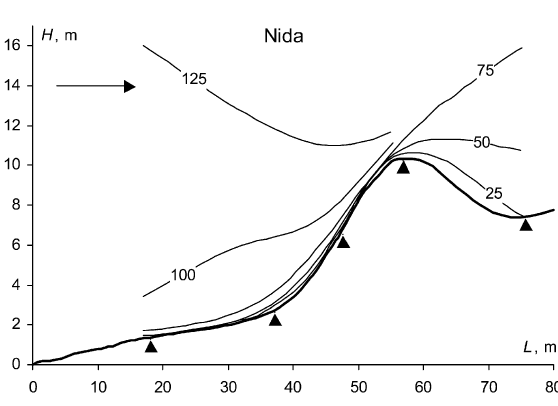
Fig. 8. Variations in wind speed (%) in the cross-shore profile near